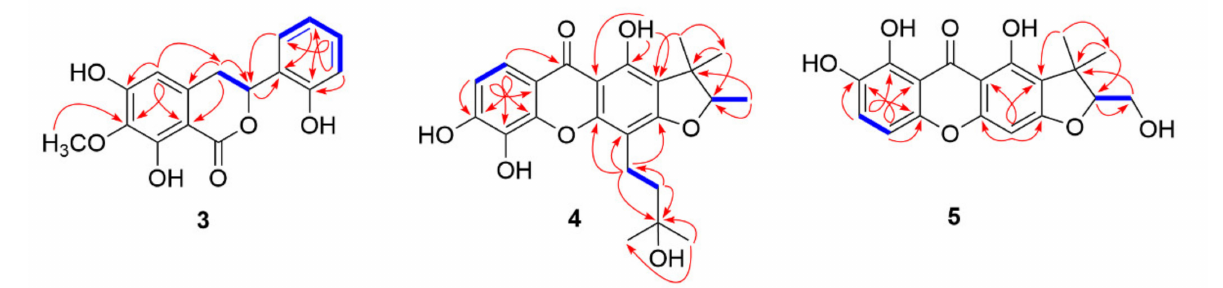
Figure 2. Key COSY (blue line) and HMBC (red arrow) correlation of compounds 3 - 5